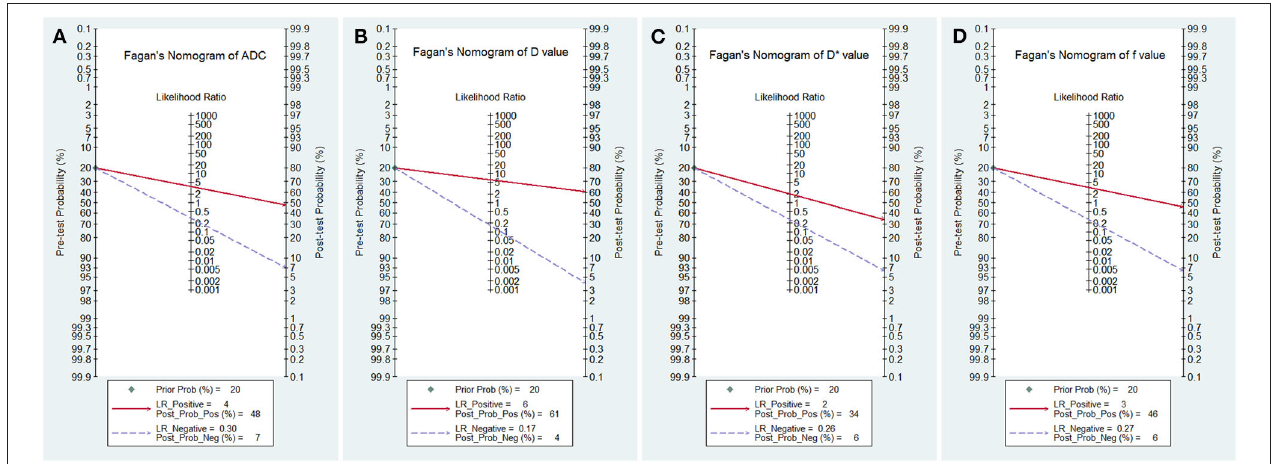
FIGURE 8 | Fagan’s nomogram of (A) the apparent diffusion coefficient (ADC), (B) tissue diffusivity (D), (C) pseudodiffusivity (D*), and (D) the perfusion fraction